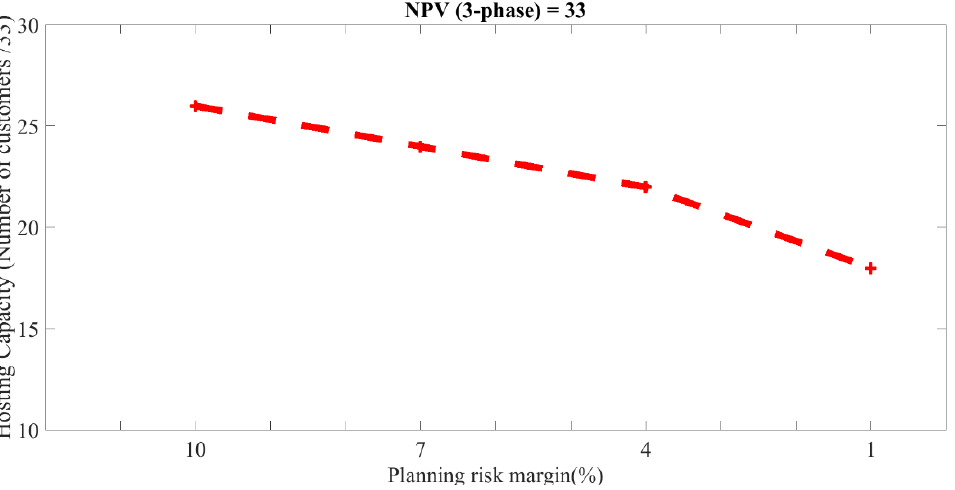
Figure 6. The hosting capacity estimations for the different stricter planning risks of a DSO.